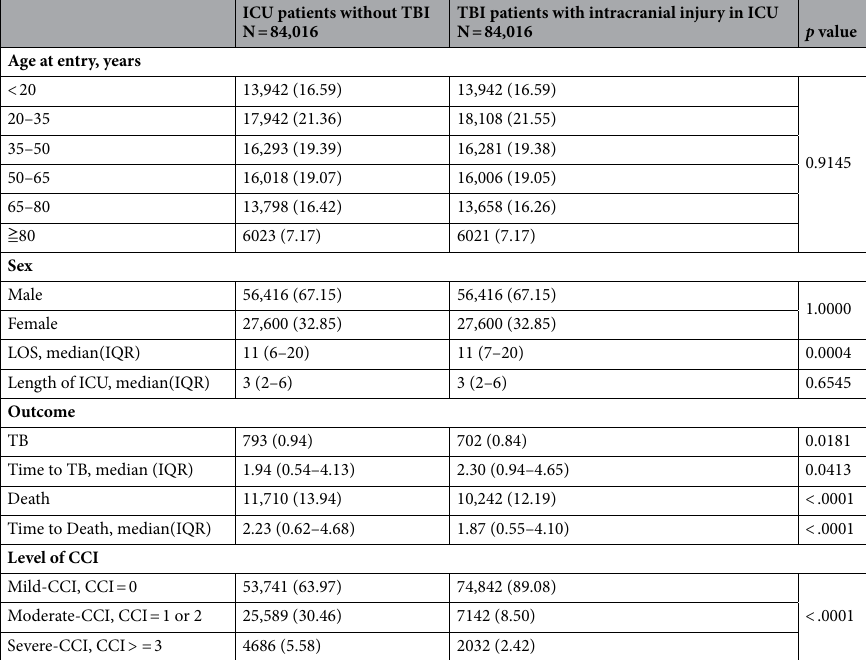
TB incidence risk Mortality